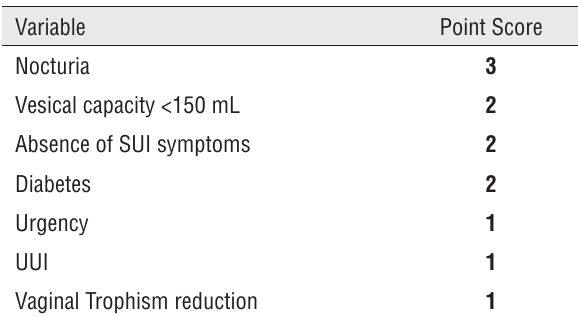
Figure 1 - OAD and OAB Score ROC